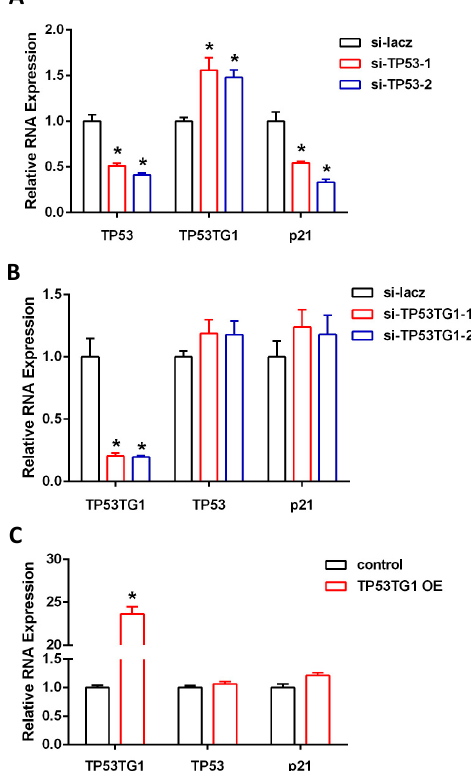
Figure 1. TP53TG1 is regulated by TP53 in HepG2. ( A – C ) qPCR analysis of TP53, TP53TG1, and p21 (normalized to 18S) in HepG2 cells transfected with lacz siRNA or TP53 siRNAs ( A ), HepG2 cells transfected with lacz siRNA or TP53TG1 siRNAs ( B ), and HepG2 cells transfected with control or TP53TG1 overexpression adenovirus ( C ). Error bars represent SEM, n = 3, * p < 0.05 (si-RNA vs. si-lacz).